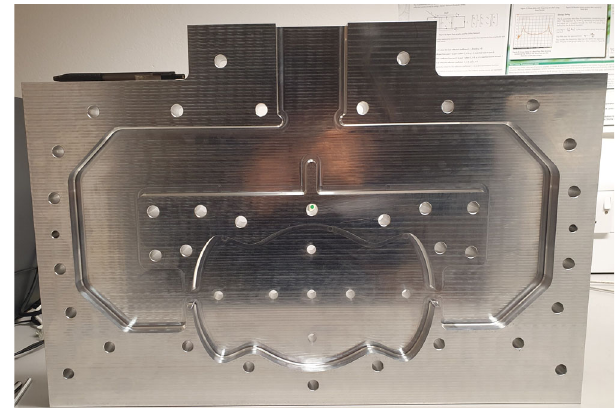
FIG. 10. Half of the rf cavity system designed to support the TM mode with quadrupolar component 5.041 times greater f 0 ; 2 g 20 than the monopolar